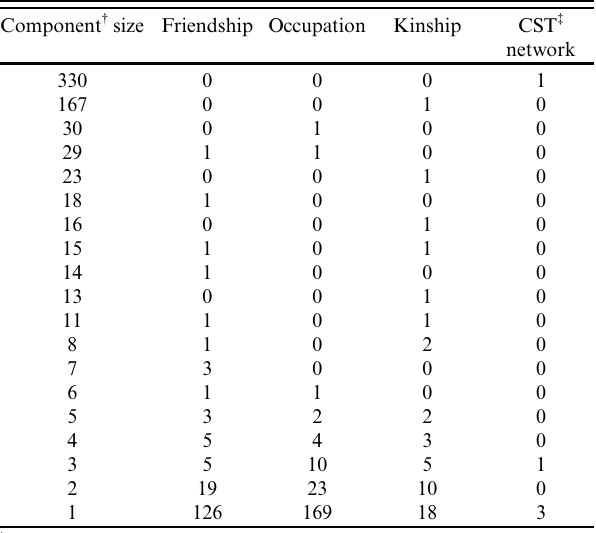
Table 3 . Distribution of component size of the strong-tie